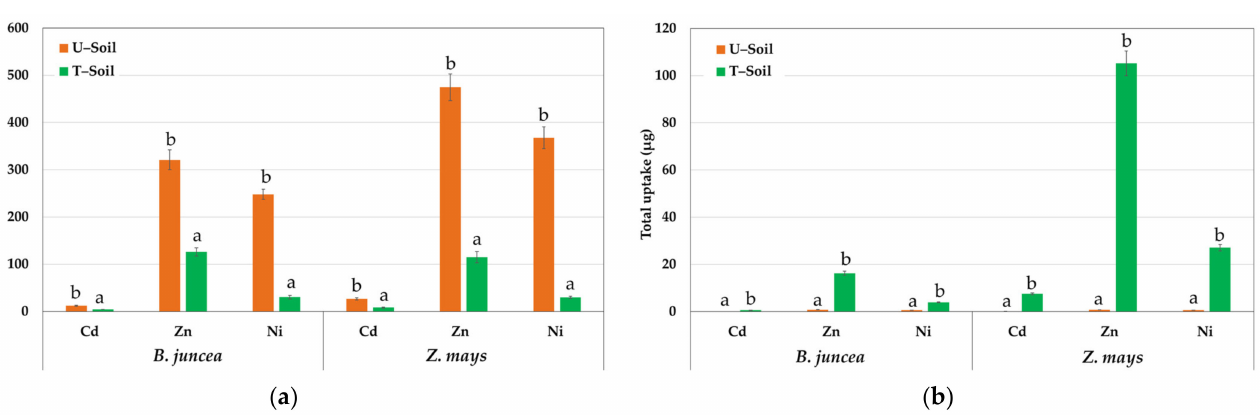
Figure 6. The contrasting trend of metal concentration (mg kg − 1 ) in the shoots of plants ( a ) and total uptake ( µ g) ( b ) in original, untreated soil (U-soil) and compost-treated soil (T-soil). Different letters indicate significant differences ( p < 0.05) between U-soil and